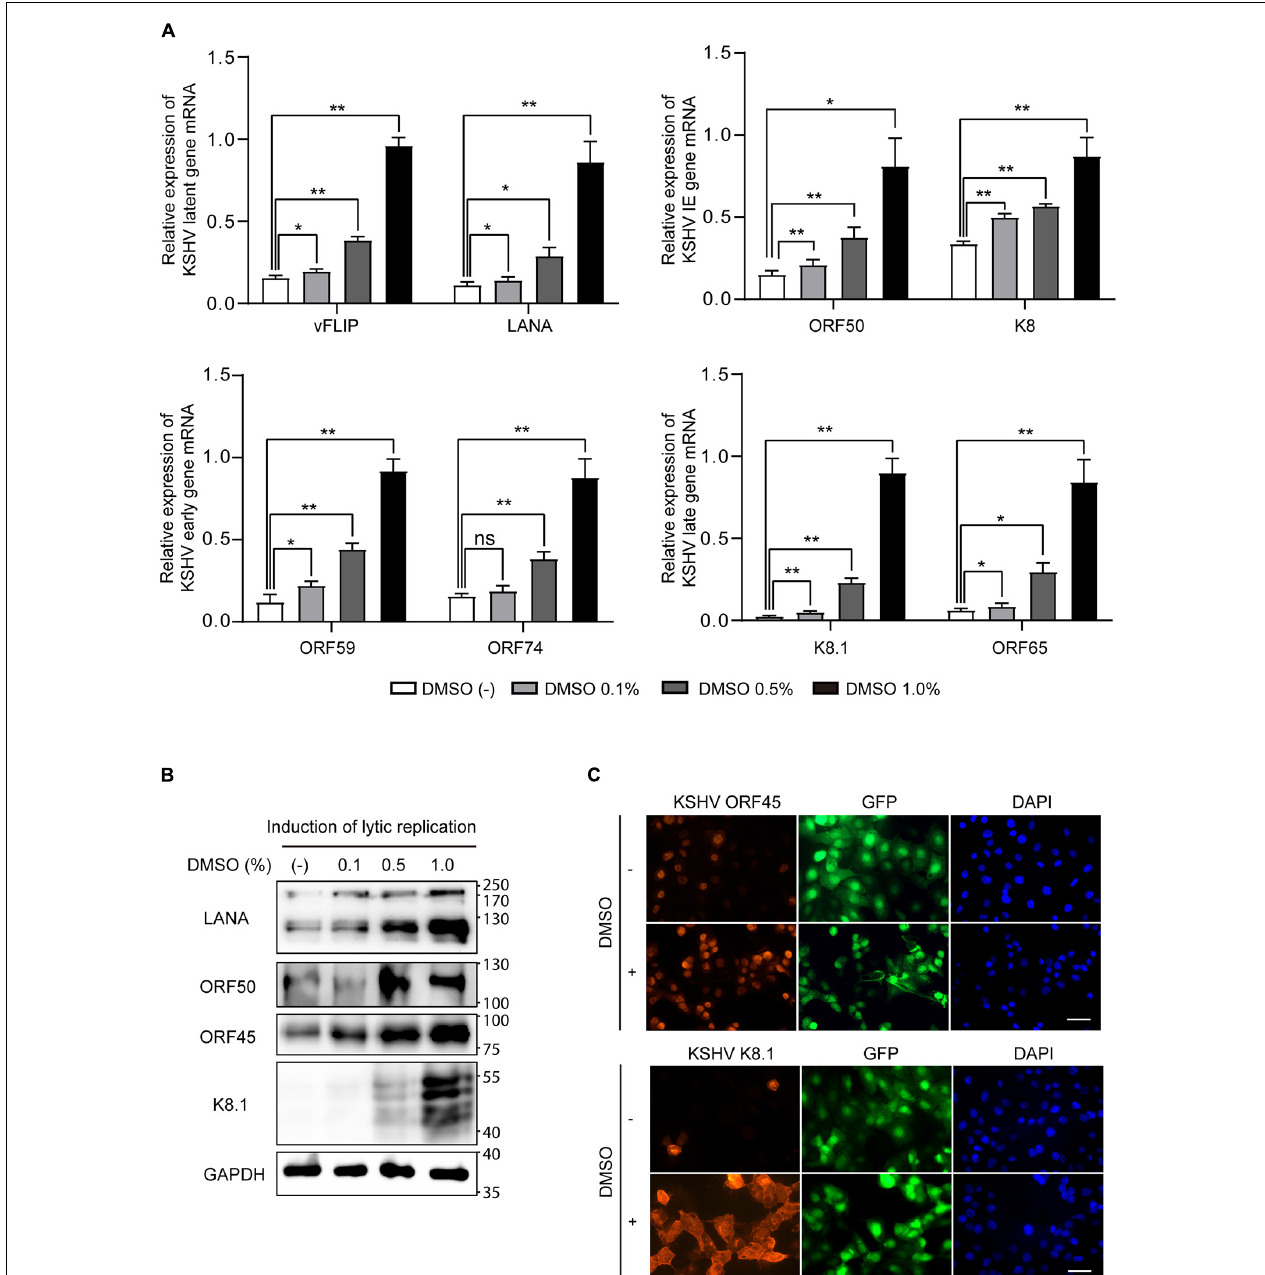
FIGURE 3 | Increased expression of viral genes by DMSO during lytic replication of KSHV. iSLK BAC16 cells were treated with various concentrations of DMSO during lytic replication. After 24 h, total RNA and protein were isolated to analyze viral gene expression. (A) RT-qPCR analysis of mRNA expression of KSHV viral genes. Data are shown as the mean ± SD, n = 3, * p < 0.05, and ** p < 0.01. (B) Western blot analysis of the indicated viral proteins in iSLK BAC16 with induction of lytic replication. (C) Immunofluorescence assay (IFA) for the indicated viral proteins in iSLK BAC16 with induction of lytic replication. DMSO (1%) was treated to cells at the beginning of lytic replication. IFA was analyzed at 24 h after induction. Scale bar = 50 µ